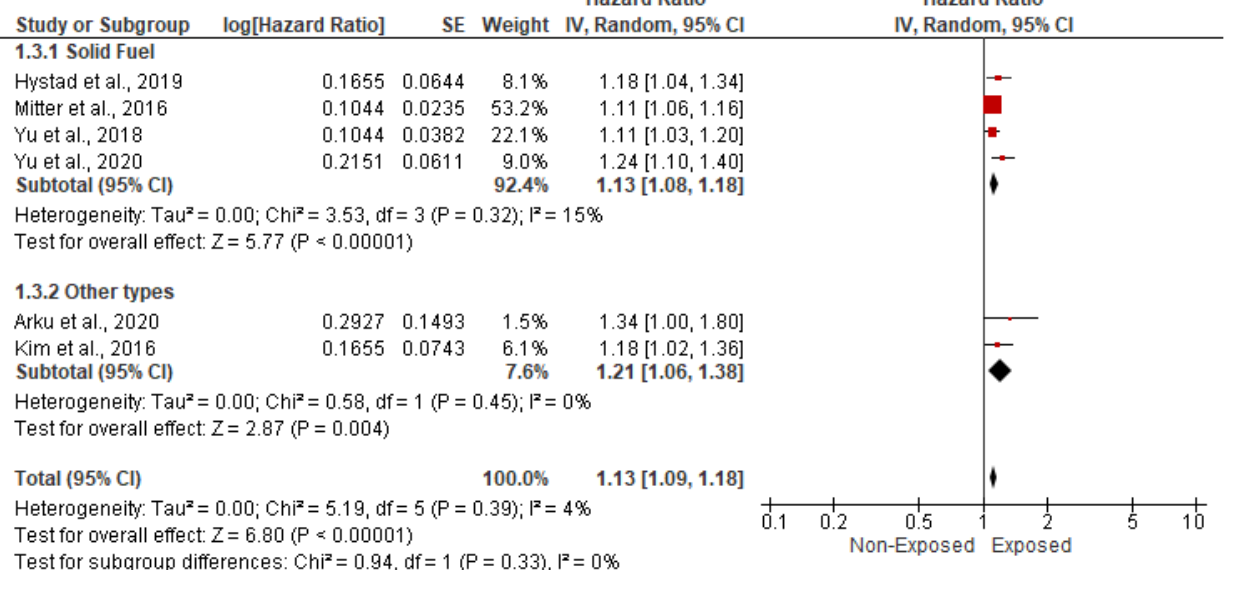
Figure 5. Forest plot of subgroup analysis of the hazard ratio and 95% CI of the association between HAP and CVD-related mortality based on types of HAP. The size of the red squares is proportional to the statistical weight of each trial. The gray diamond represents the pooled point estimate. The positioning of both diamonds and squares (along with 95% CIs) beyond the vertical line (unit value) suggests a significant outcome (IV = inverse variance).